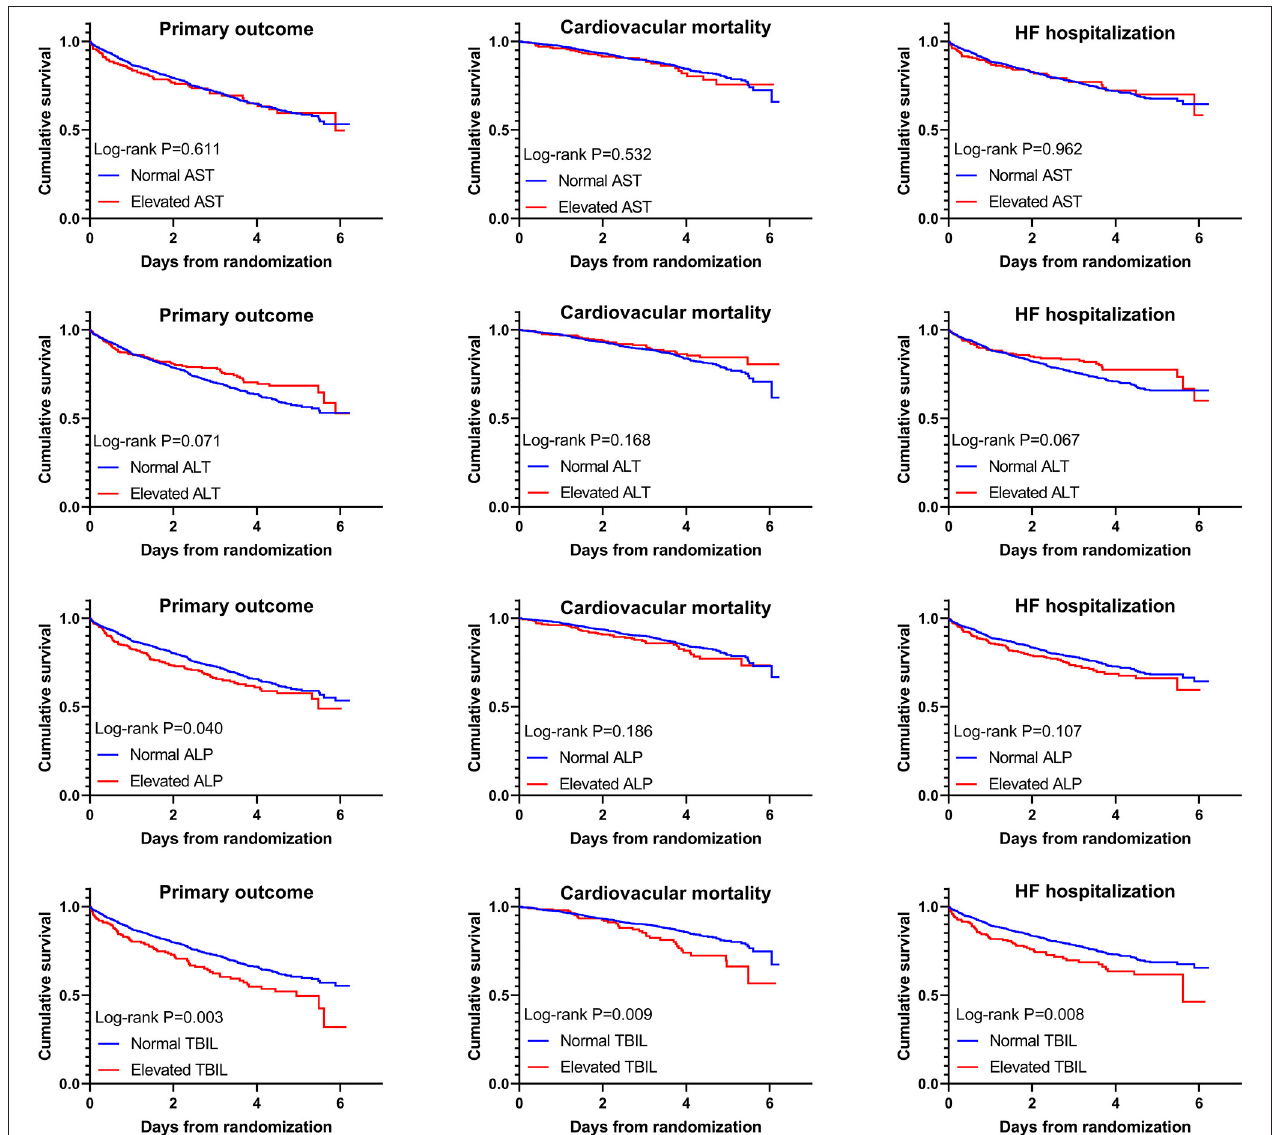
FIGURE 1 | Kaplan–Meier curves with log-rank tests for comparison of elevated vs. normal aspartate transaminase (AST), alanine transaminase (ALT), total bilirubin (TBIL), and alkaline phosphatase (ALP) to primary and secondary outcomes.